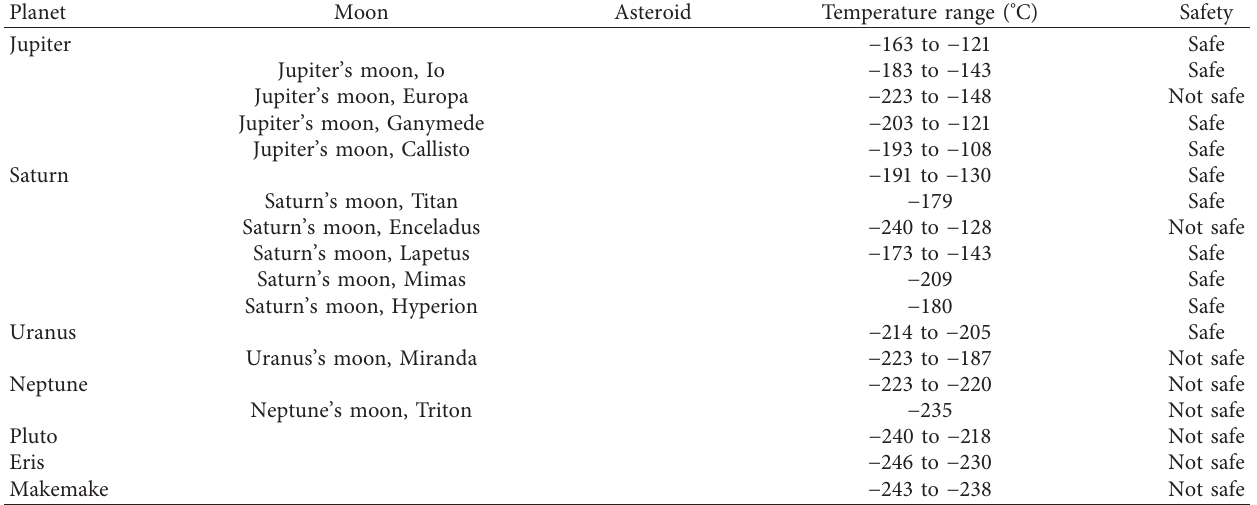
Table 2: Safe planets, moons, and asteroids for UD CFRE in the outer solar system